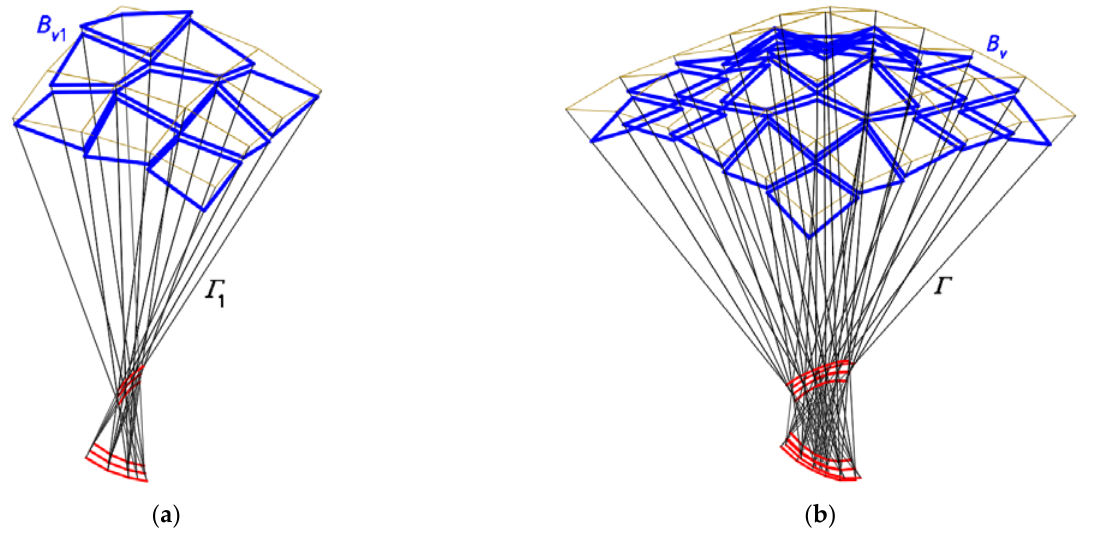
Figure 15. The results of the further steps of the method’s algorithm used for creating Γ : ( a ) Γ 21 ; ( b ) Γ 22 .